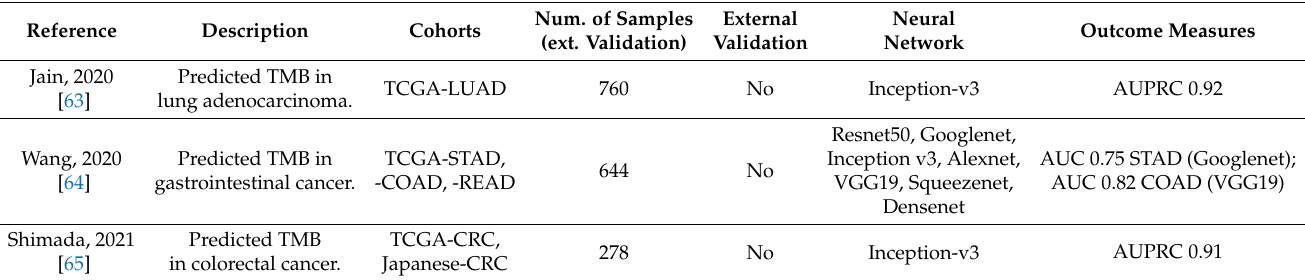
Table 3. Comparison of studies aimed at predicting tumour mutational burden from digitised histopathology slides using deep